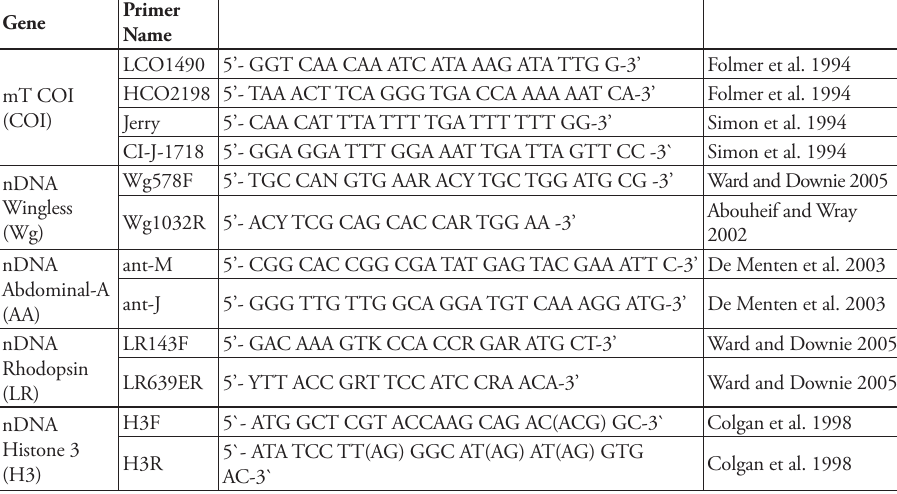
table 1. Primers used during this